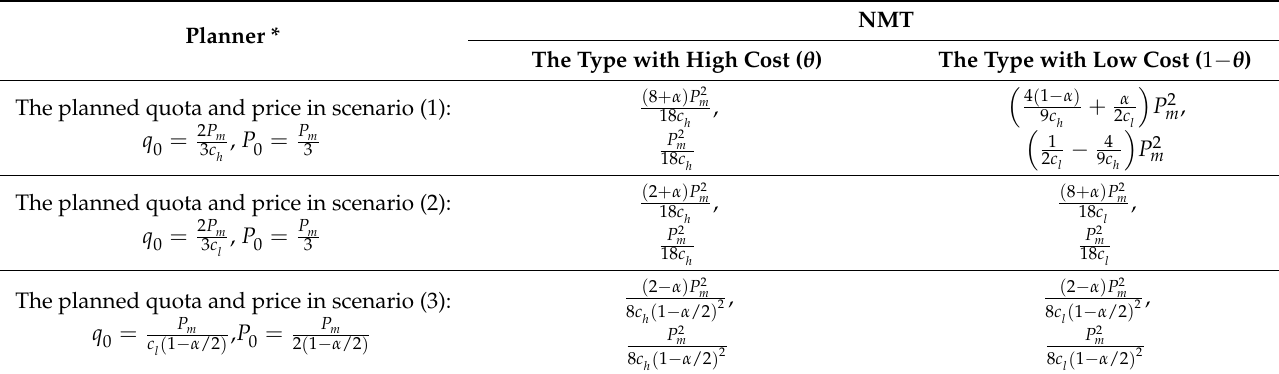
Table 1. Payoff matrix of the planner and the NMT *